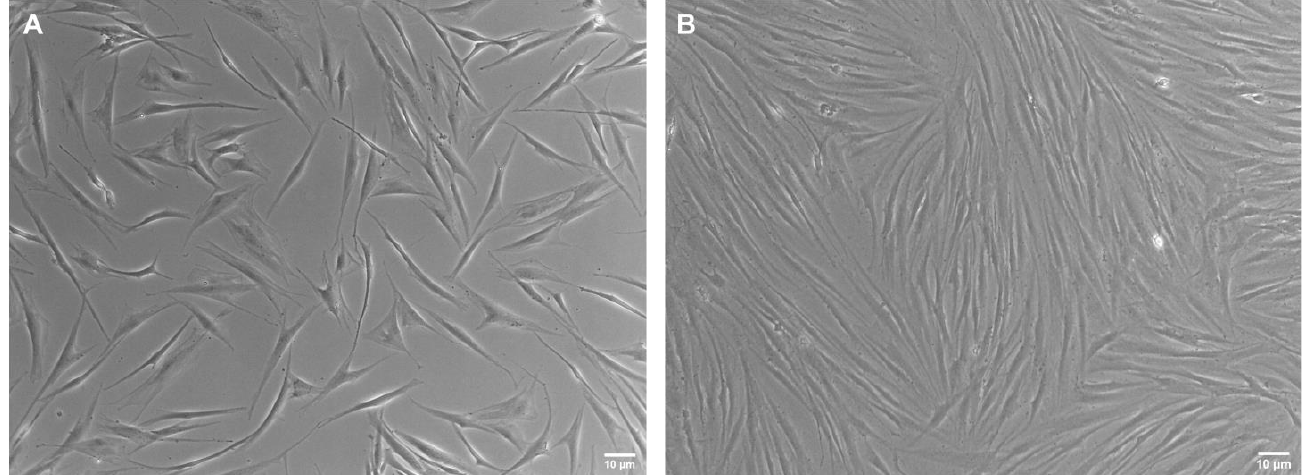
Figure 10. Phase-contrast pictures . Images showing different cell confluence percentages. ( A ) Cells plated with a low percentage of confluency (around 50%) and ( B ) with a high percentage of confluency (around 90%).